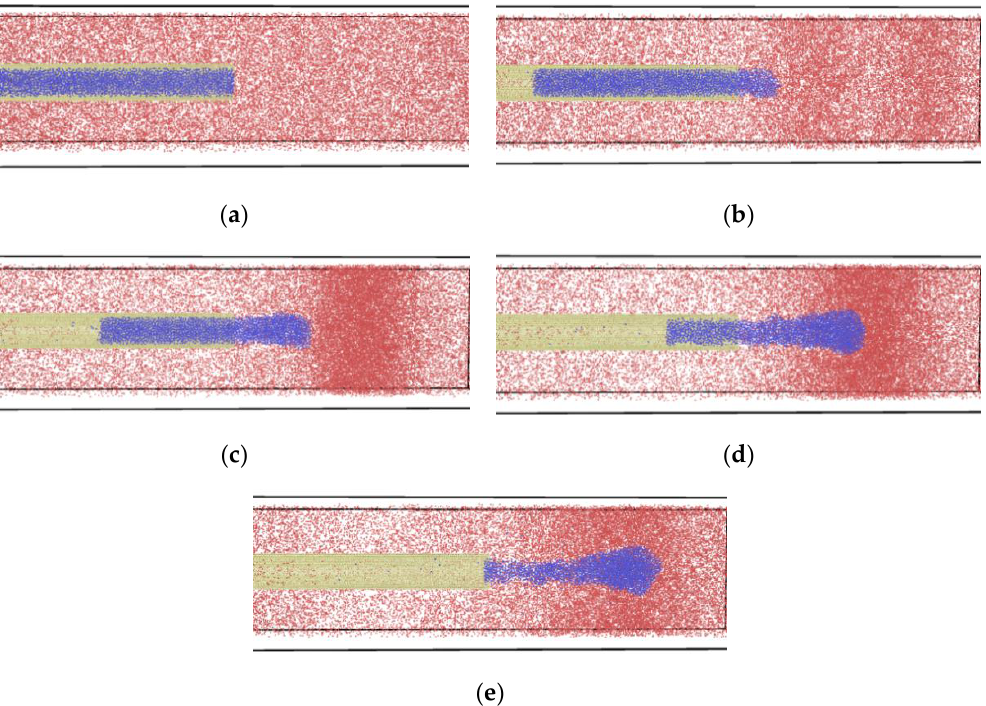
Figure 11. Development of subcritical nitrogen jet (7.5 MPa, 120 K) sprayed into supercritical argon environment (5.5 MPa, 200 K): ( a ) t = t 0 ; ( b ) t = t 0 + 25 ps; ( c ) t = t 0 + 50 ps; ( d ) t = t 0 + 75 ps; ( e ) t = t 0 + 100 ps.